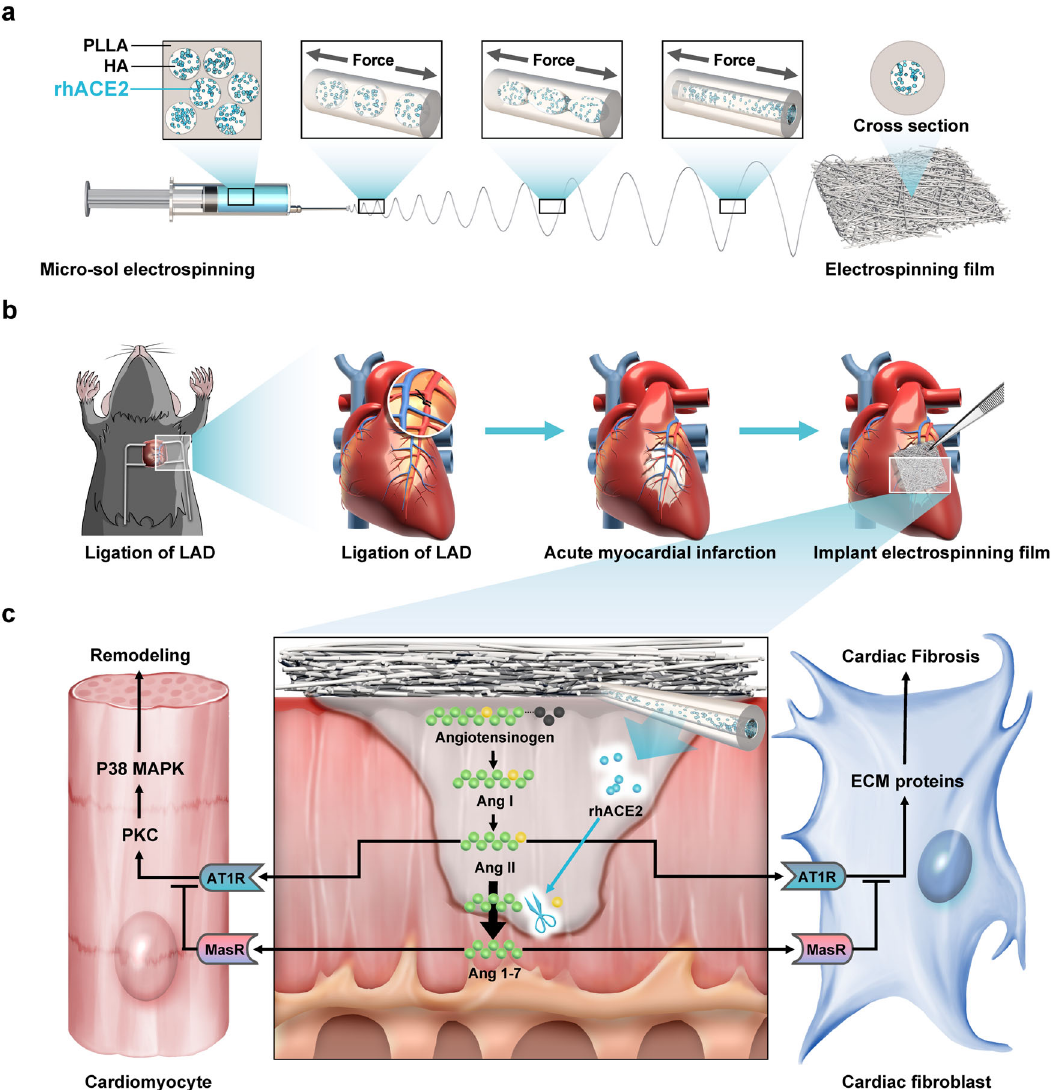
Fig. 1 Schematic Illustration. a Preparation of rhACE2-loaded electrospun nano fi ber patch by hyaluronan (HA) micro-sol electrospun and the mechanism of formation of core-shell structure. b Myocardial infarction mice model established by precise ligation of the left anterior descending (LAD) coronary artery along with the illustration of rhACE2 patch implantation. c In situ rhACE2 patch niche degrading angiotensin II (AngII) into a cardioprotective heptapeptide, Ang1 – 7, which counter the AngII/AT1R mediated effects by inhibiting cardiac fi brosis and cardiomyocyte apoptosis. PLLA poly(L-lactic acid), rhACE2 recombinant human angiotensin-converting enzyme 2, AT1R angiotensin II receptor type 1, PKC protein kinase C, MAPK mitogen-activated protein kinase, ECM extracellular